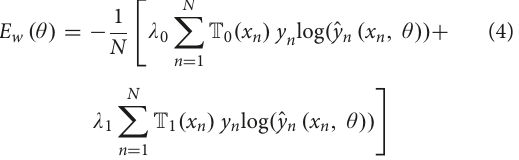
y ∈ { 0 , 1 } C denote a binary one-hot encoded label with C 2